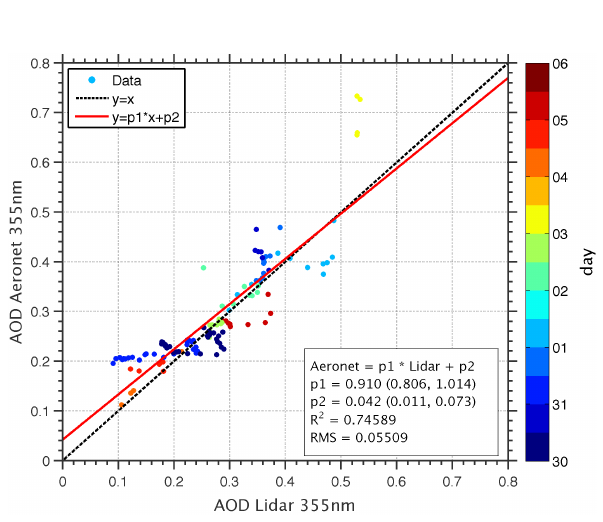
Figure 16. Aerosol optical depth at 355nm from AERONET as a function of that obtained from the elastic inversion is shown for the coincident measurements between 30 and 6 September 2011. Lidar extinction profiles were averaged in a 30min window and in- tegrated from the reference altitude down to the ground, assuming a constant extinction below 1.3km.